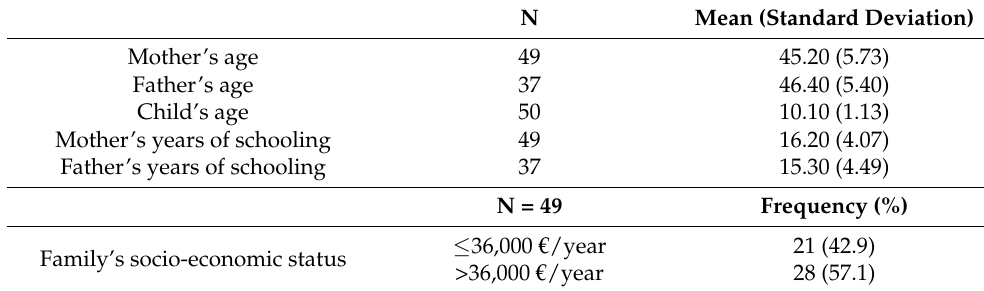
Table 1. Socio-demographic characteristics of the sample.